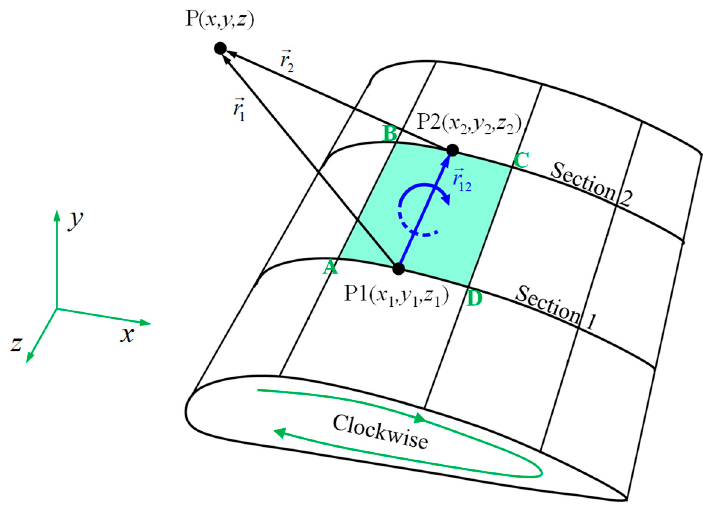
Figure 5. Contours of relative error (Airfoil S809, α = 6 ◦ , Reynolds number = 1 × 10 6 ).